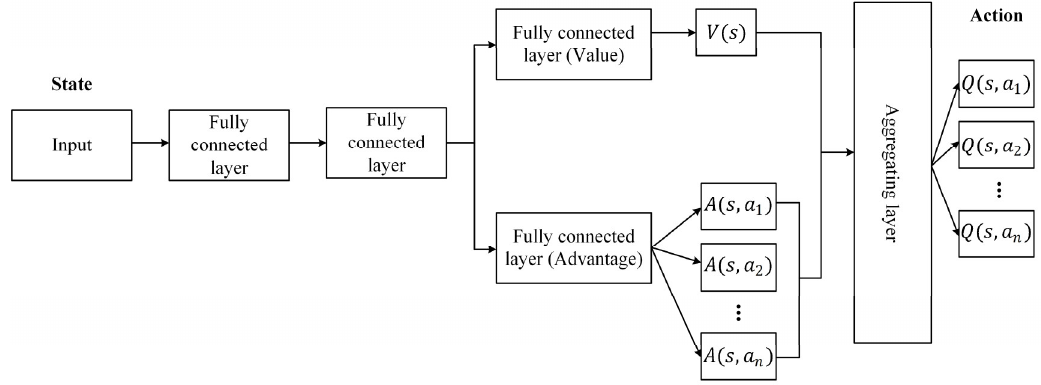
Figure 13. Structure of D3QN.